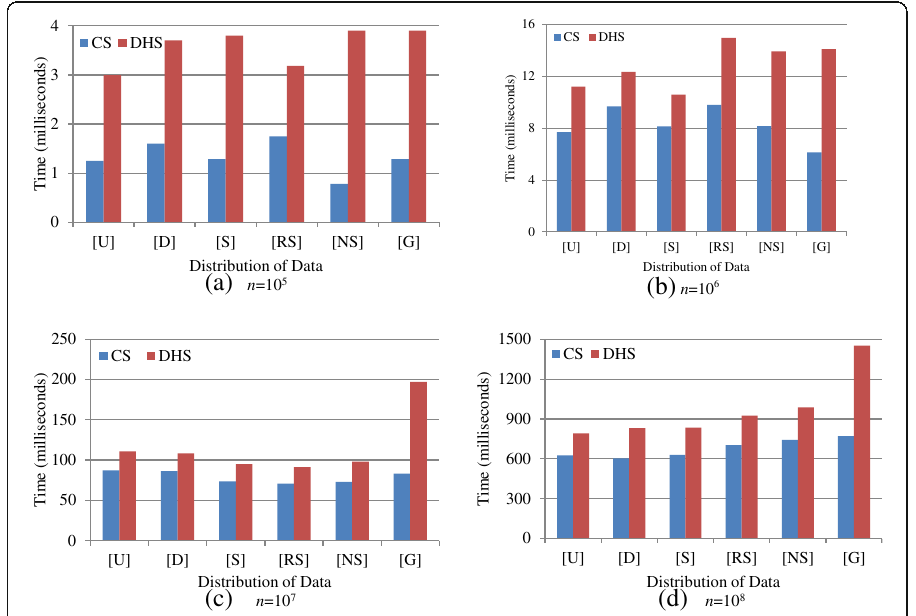
Fig. 3 Running time for the CS and DHS algorithms in case of O ( m ) < O ( n ). a n = 10 5 . b n = 10 6 . c n = 10 7 . d n = 10